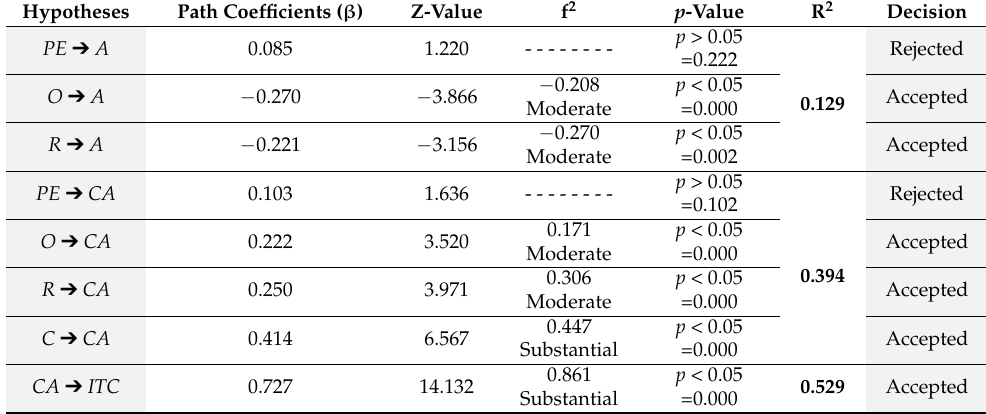
Table 5. The Results of Testing Hypotheses.